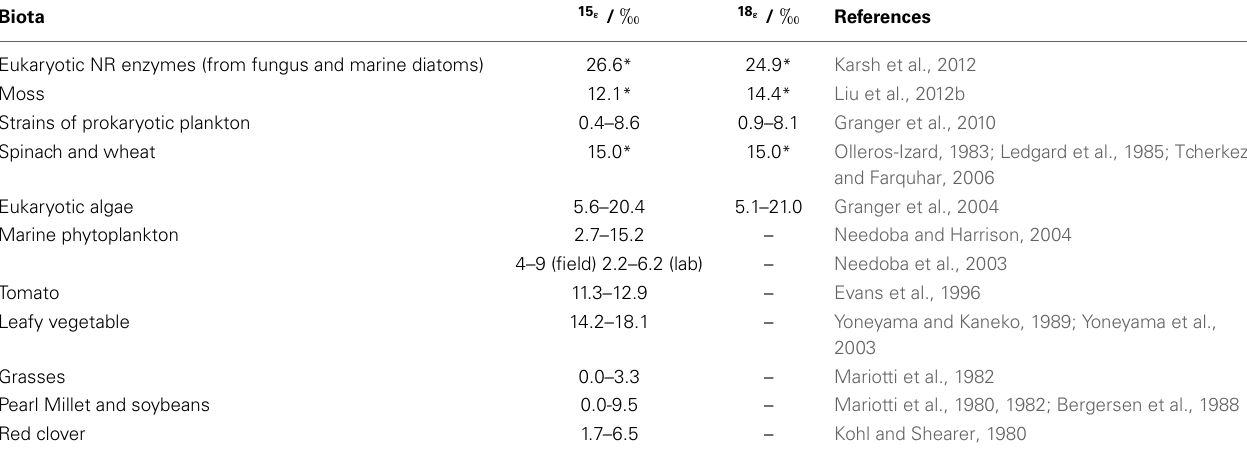
reduction ( * ) or net NO − 3